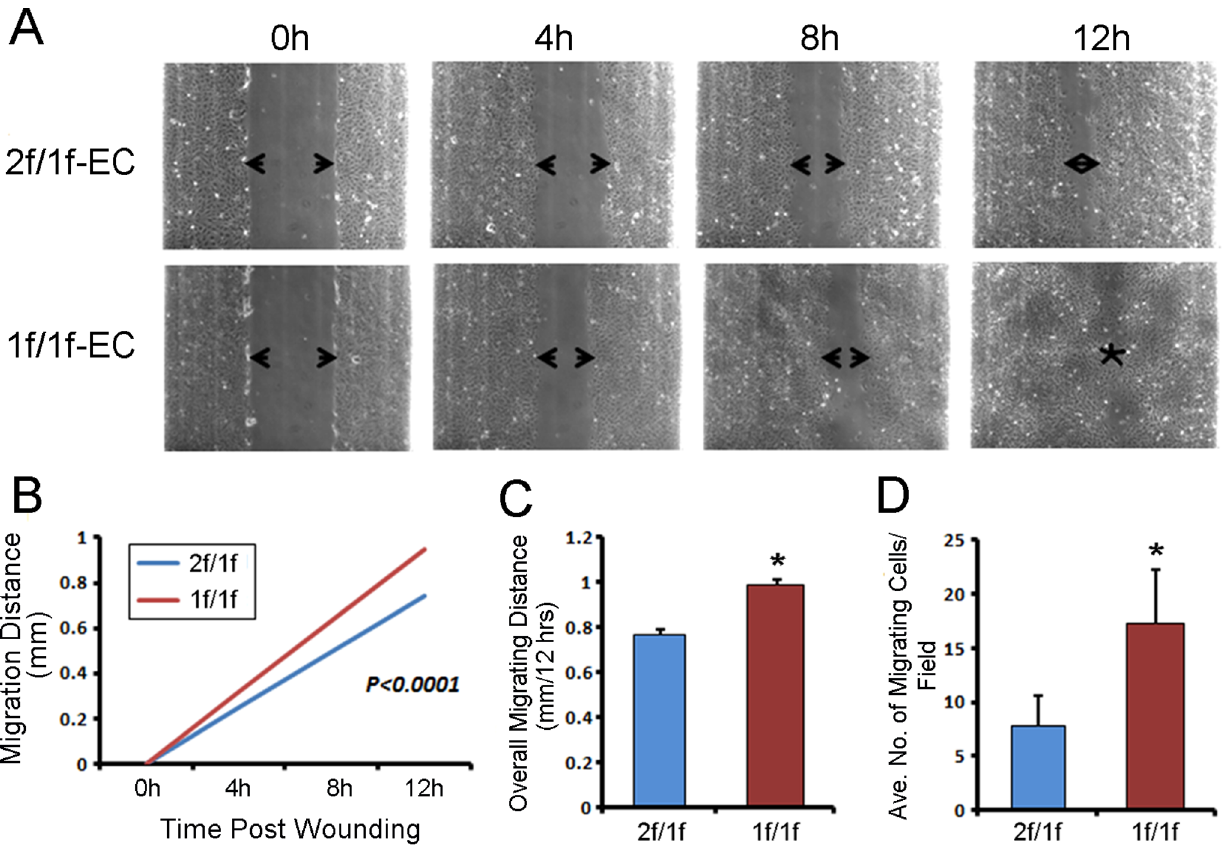
Figure 2. Alk1 -null pulmonary ECs displayed elevated migratory index upon angiogenic factor challenge. A. Time-lapse images of scratch-wound closure of 2f/1f- and 1f/1f-ECs in response to bFGF (50 ng/ml). At 12 hours post-wounding, mutant cells almost completely closed the wound, while the wound was still present in the control culture. B. Statistical analysis shows that the rate of wound closure in 1f/1f-ECs was higher than that in 2f/1f-ECs. C. Migration distance of 1f/1f-ECs at the 12-hour time point was higher than that of 2f/1f-ECs. D. In the 3D modified Boyden chamber assay, significantly more migrating 1f/1f-ECs were counted in six randomly chosen fields as compared with 2f/1f-ECs. Note that all data represent means from three independent experiments. Error bars show standard errors. *p , 0.05.